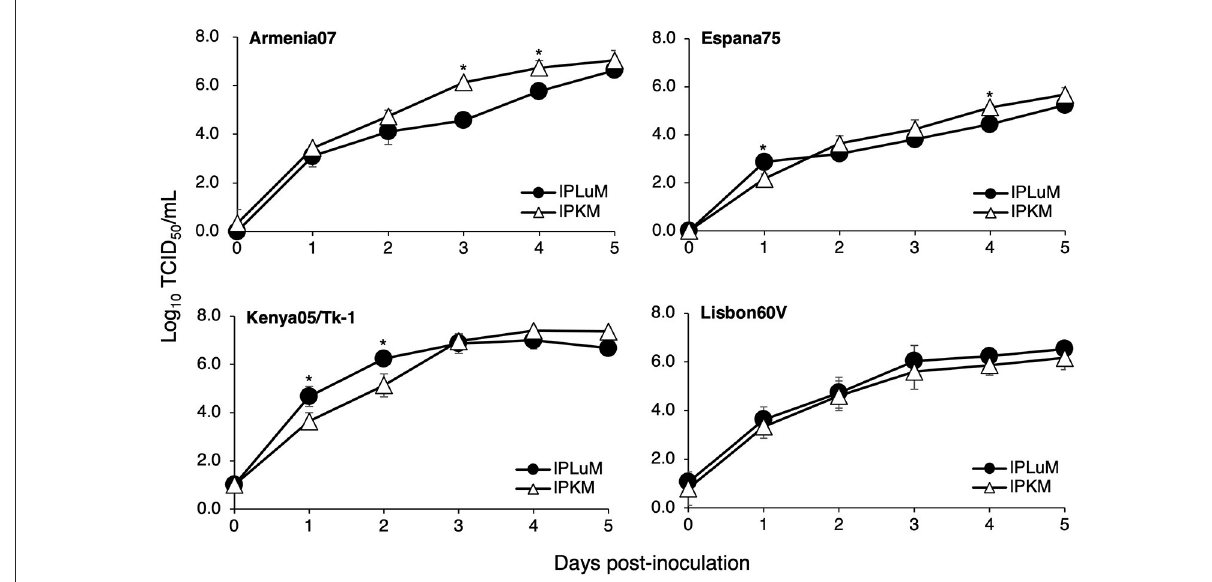
FIGURE4 Comparison of ASFV production in IPLuM and IPKM. Cell cultures were infected with Armina07, Kenya05/Tk-1, Espana75, or Lisbon60V isolates (MOI = 0.001). Culture supernatant samples were collected at the indicated timepoints. Viral production in the IPLuM (closed circles) and IPKM (open triangles) cell cultures was estimated by titration experiments with the IPKM. Data represent the mean and standard deviation of three experiments. Asterisks indicate statistically significant differences in viral production between the IPLuM and IPKM cell cultures (* p <